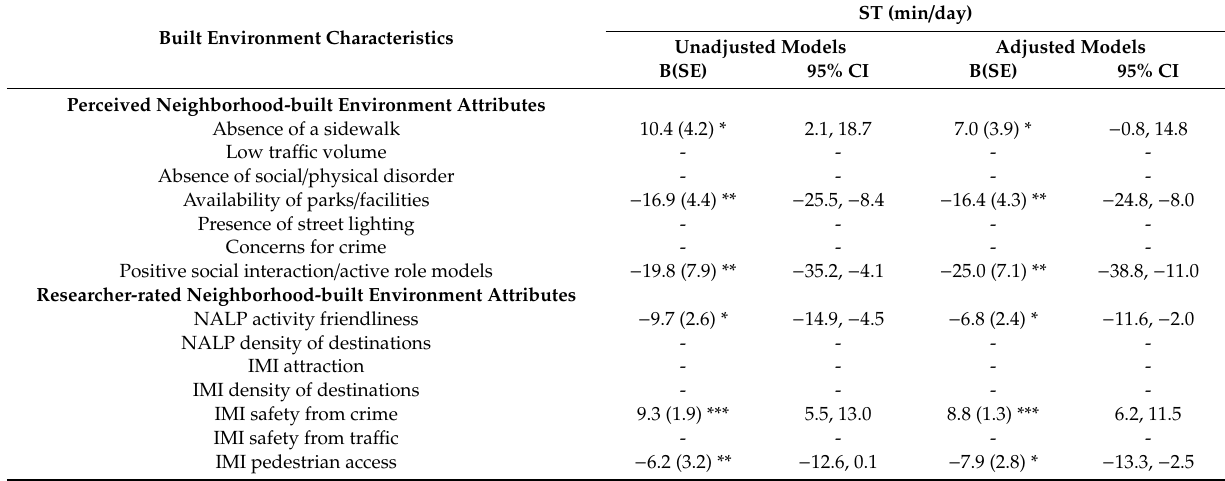
Table 4. Associations between BE characteristics and average daily minutes of ST (only significant associations from the final model